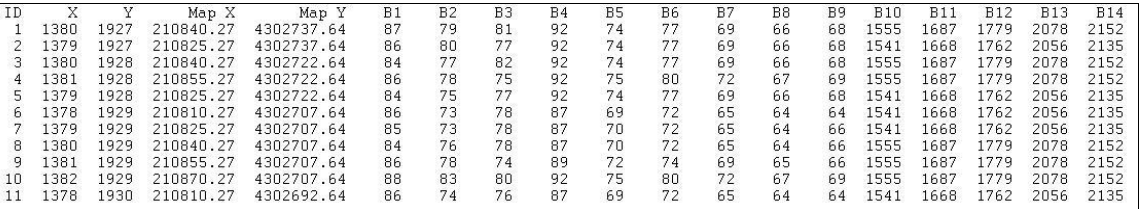
Figure 5. Fragment of the ROI ASCII export